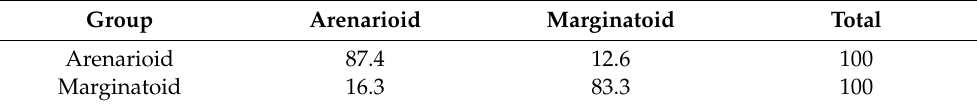
Table 5. Confusion matrix of the LDA based on the seed morpho–colorimetric dataset (percentages of correct classification), assuming “arenarioid” and “marginatoid” groups for Armeria arenaria populations. Rows show the membership of each a priori established group, whereas columns show the membership predicted by the classification model.